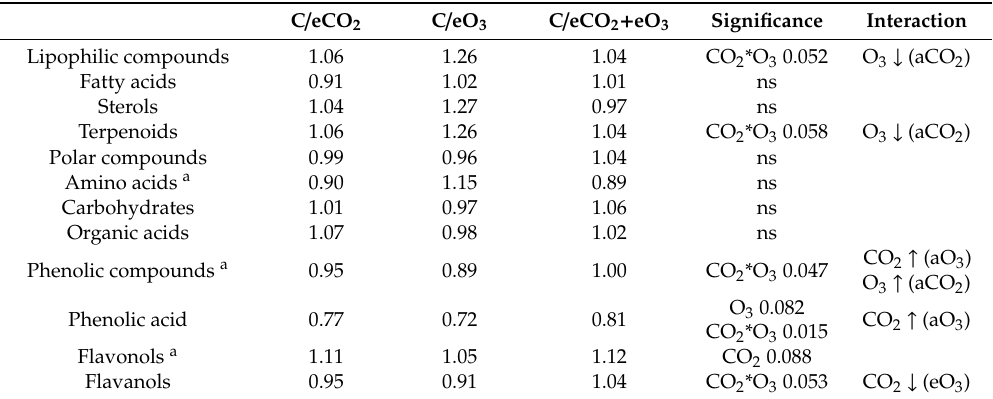
Table 2. Total relative content of lipophilic, polar and phenolic compounds and the relative content of the major metabolite groups in birch buds collected on April 4, 2009 at the Aspen FACE